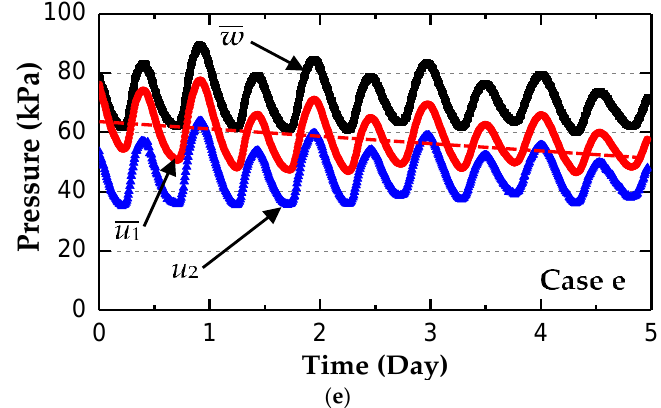
Figure 5. Field test results of total stress and pore water pressure during the sitting time of ( a ) 3 h, ( b ) 6 h, ( c ) 22 h, ( d ) 2.5 days, and ( e ) 5 days.